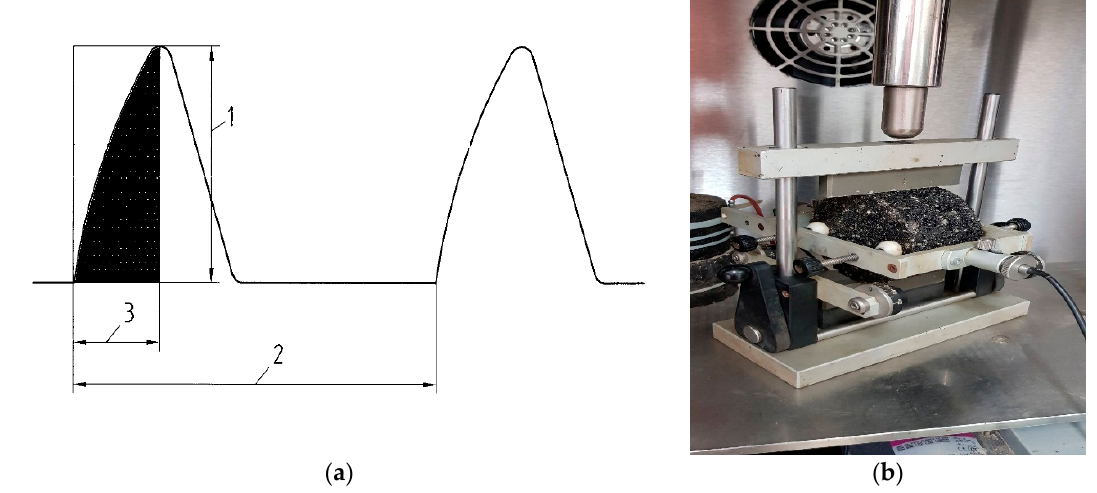
Figure 4. An example of a force applied to the specimen and the loading scheme [71]: ( a ) loading pulse form (1: maximum loading, 2: periodical force pulse, 3: force increase time), ( b ) set-up for indirect tensile stiffness modulus test; laboratory at Kielce University of Technology, (source: M. M. Iwa ń ski).